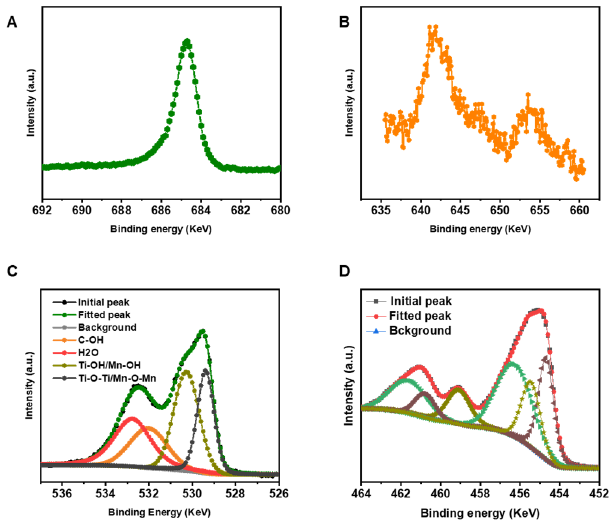
Figure 5. XPS spectrum of MnO 2 /MXene composite films: ( A ) is F1s, ( B ) is Mn2p, ( C ) is O1s, and ( D ) is Ti2p.